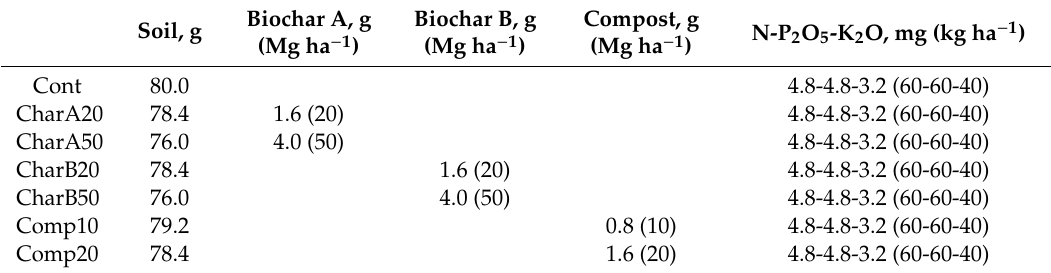
Table 3. Application rate of organic materials and chemical fertilizers for the 250 mL jars (corresponding field application